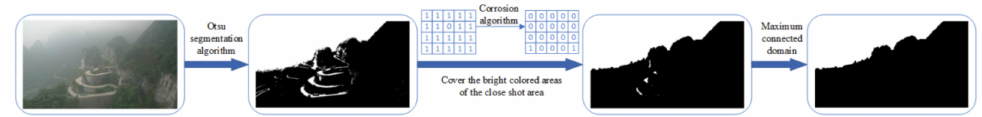
Figure 2. Flow chart of two-dimensional Otsu remote sensing image segmentation algorithm.